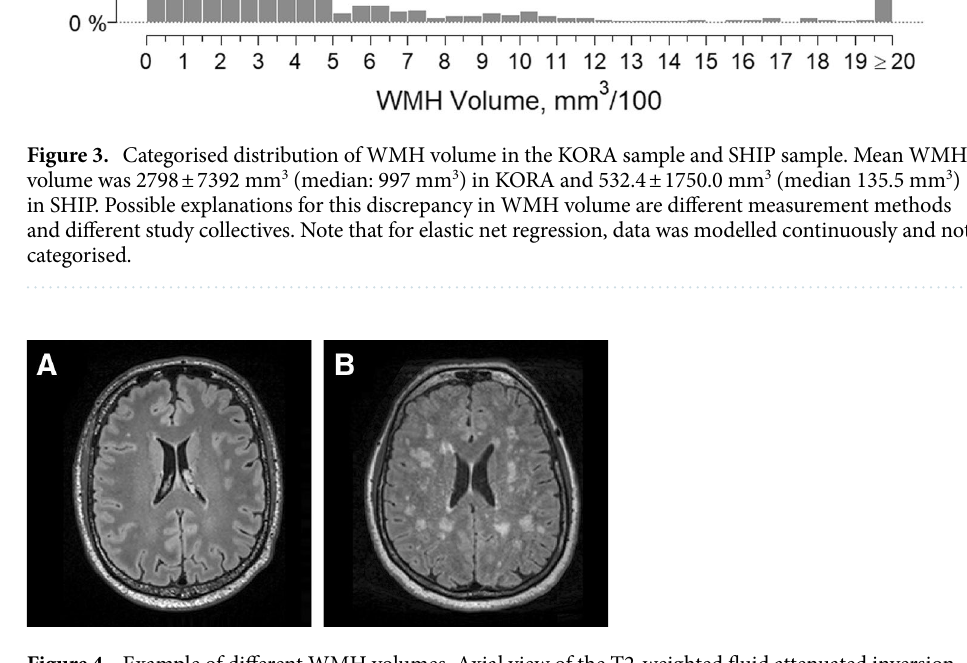
Figure 4. Example of different WMH volumes. Axial view of the T2-weighted fluid attenuated inversion recovery data of a subject with low WMH volume of 58 mm 3 ( A ) and of a subject with high WMH volume of 31,300 mm 3 ( B